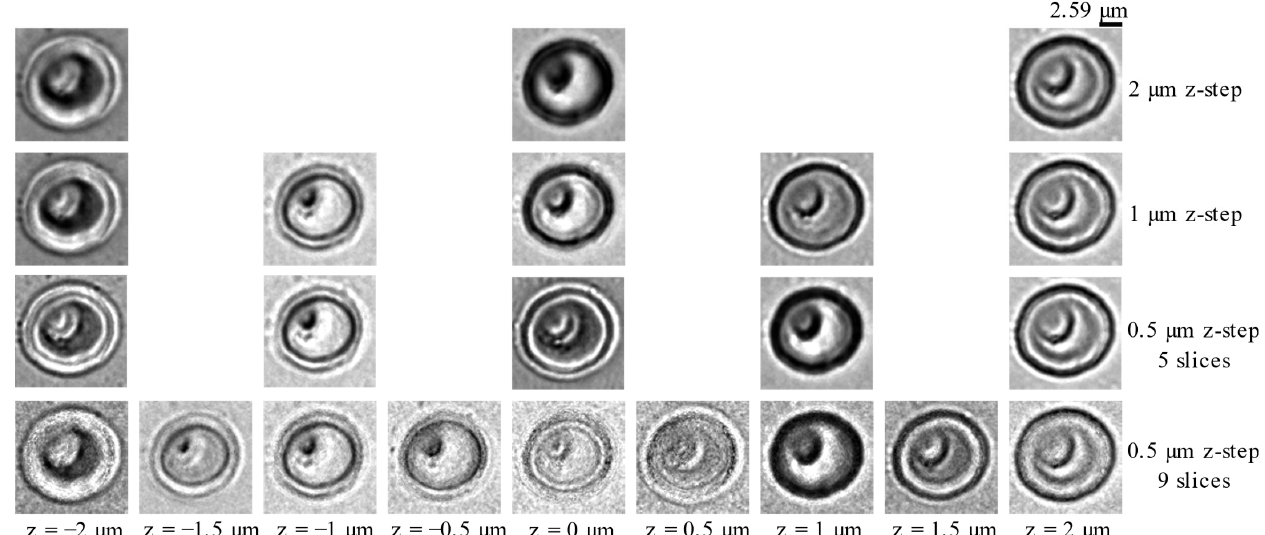
Figure 8. MCR images of RBC with inner earphone shape for different z-steps.